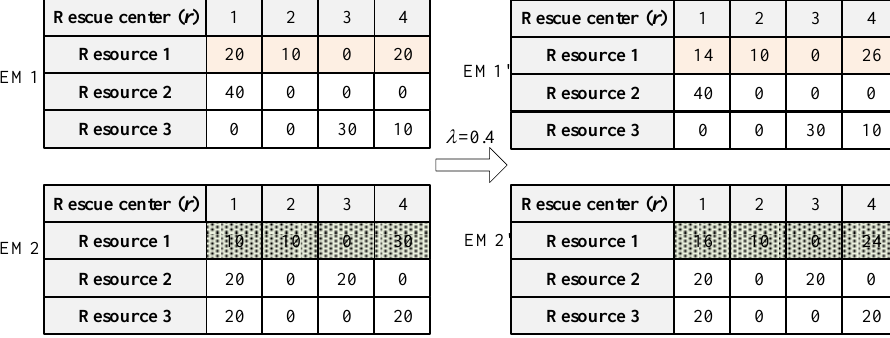
Figure 4. Illustration of crossover for sub-chromosome EM. For sub-chromosome k, generate a random integer number r ∈ [ 1, R ] and exchange genes in location r of two parent sub-chromosomes. The crossover process for sub-chromosome k is illustrated in Figure 5.